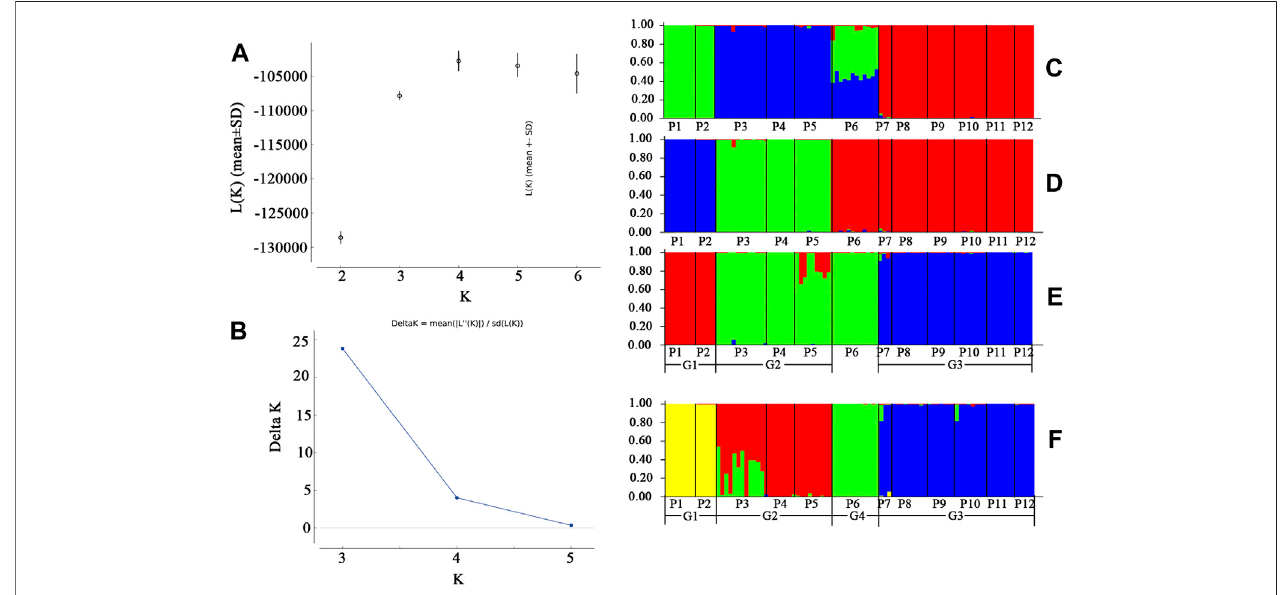
FIGURE6 | Unrooted maximum likelihood phylogenetic treeconstructed from the 94individualsof Primulinadanxiaensis based on dataset T. P1 – P12:population ID for the 12 populations of P. danxiaensis .